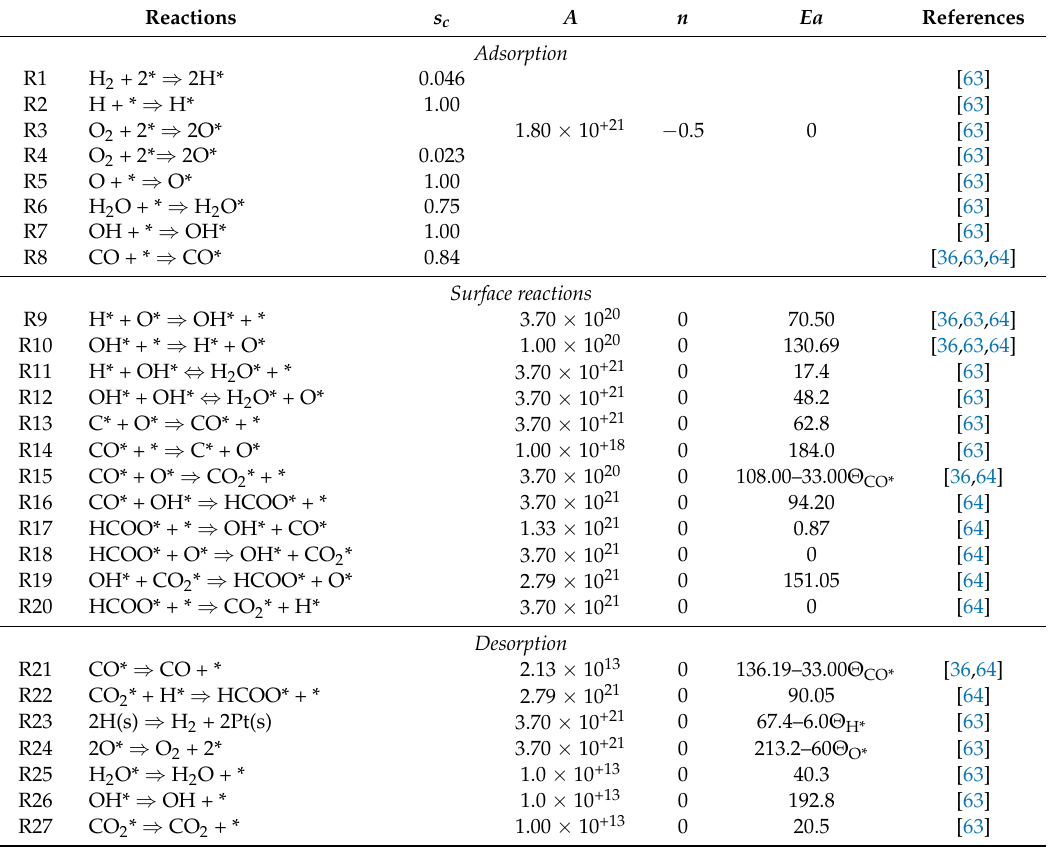
Table 1. Updated surface reaction mechanism for the low-temperature catalytic oxidation of hydrogen and carbon monoxide over